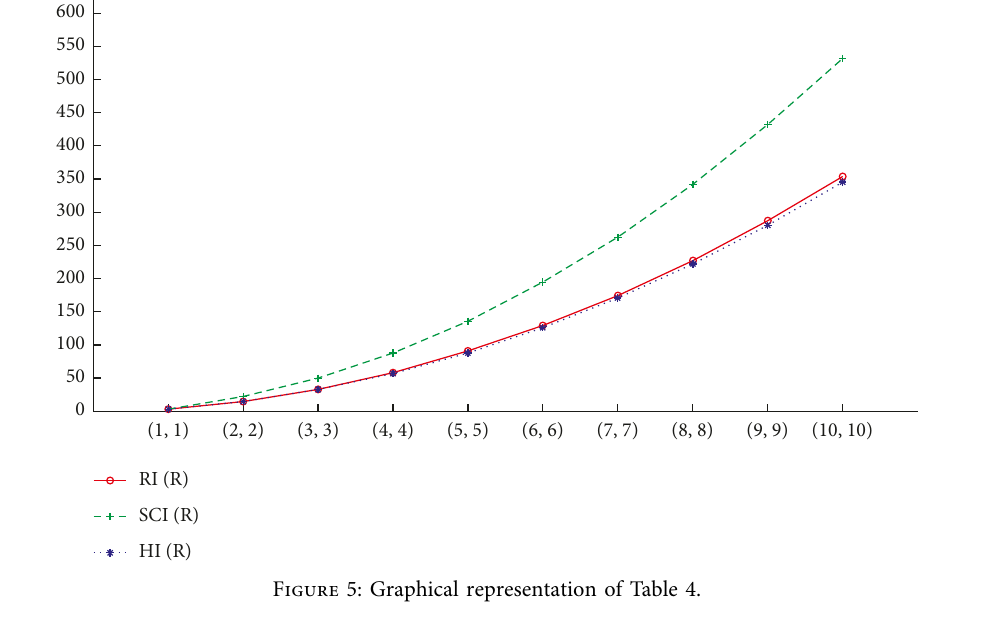
Figure 5: Graphical representation of Table 4.